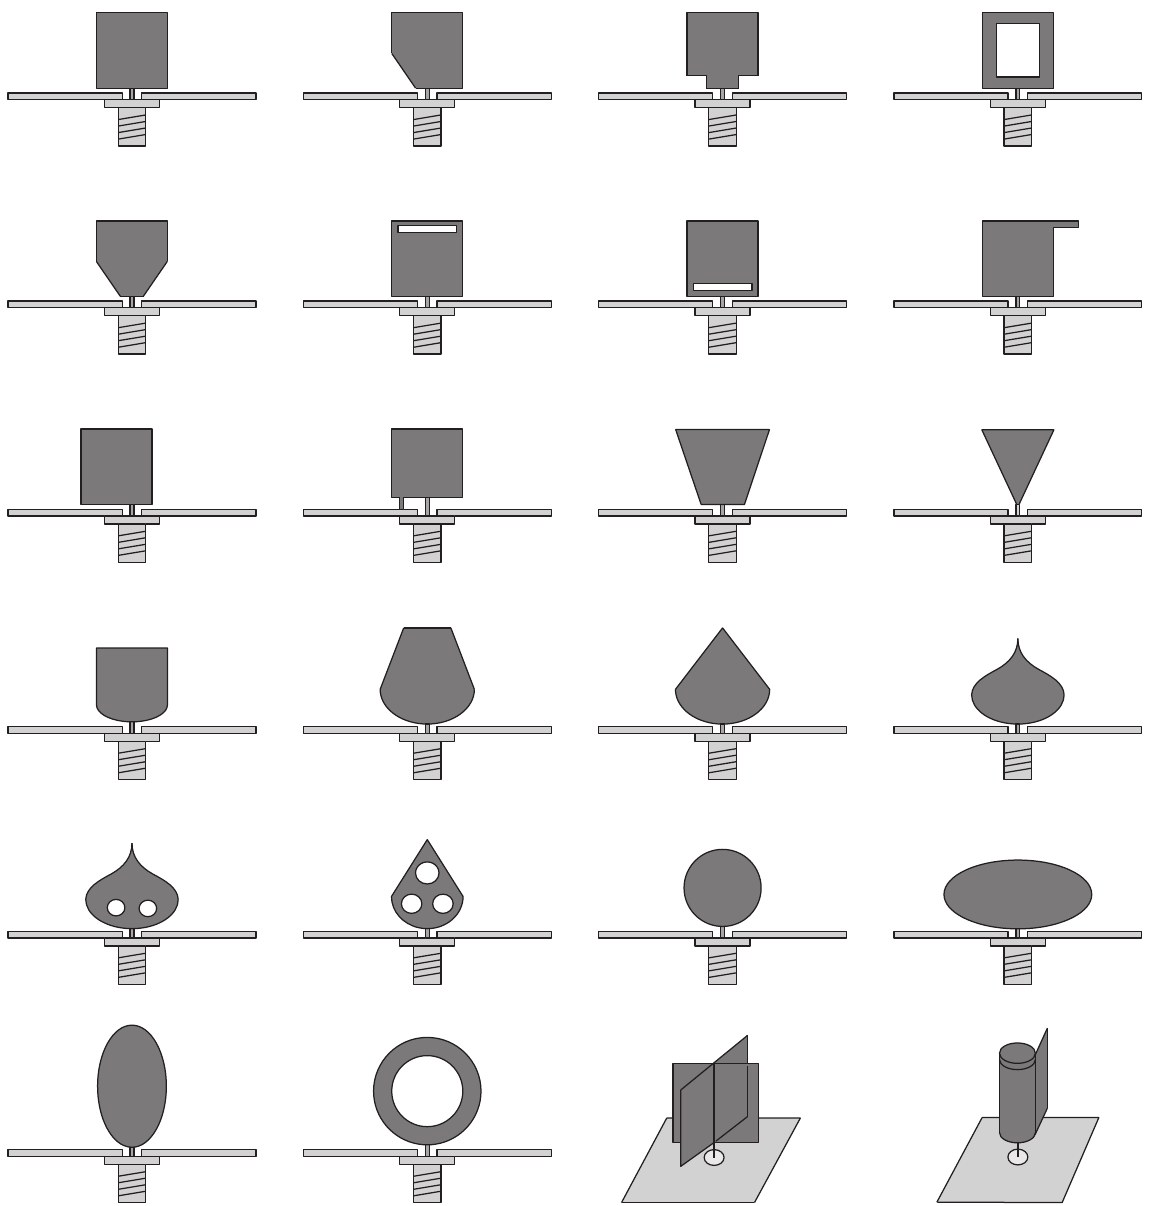
Figure 4: Examples of broadband and UWB monopole antennas over a metal plate. Dark gray monopole, medium gray ground plane, and light gray dielectric